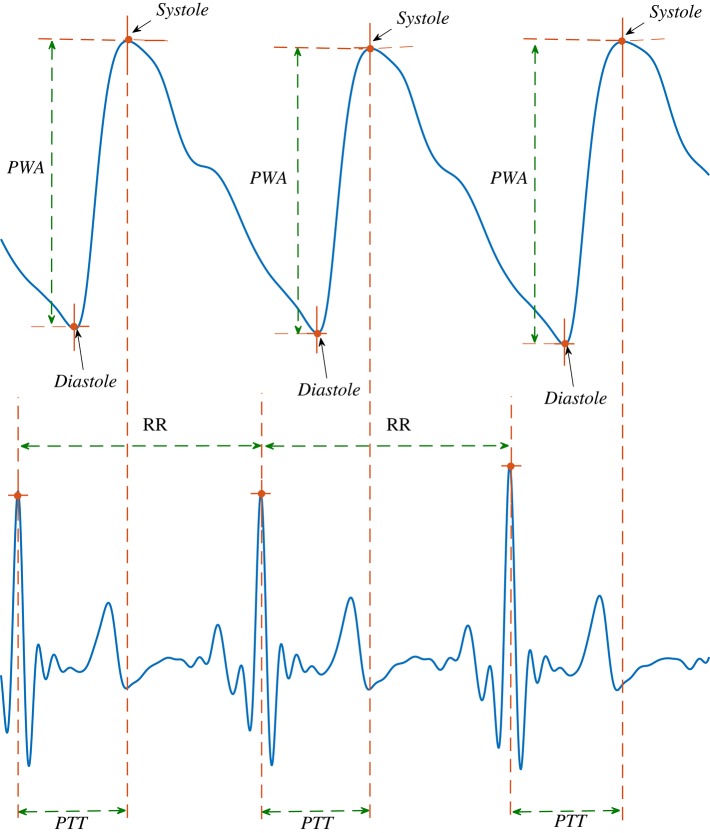
Feature (Systole, Diastole, PWA and PTT) extraction from simultaneously recorded ECG and PPG signals.